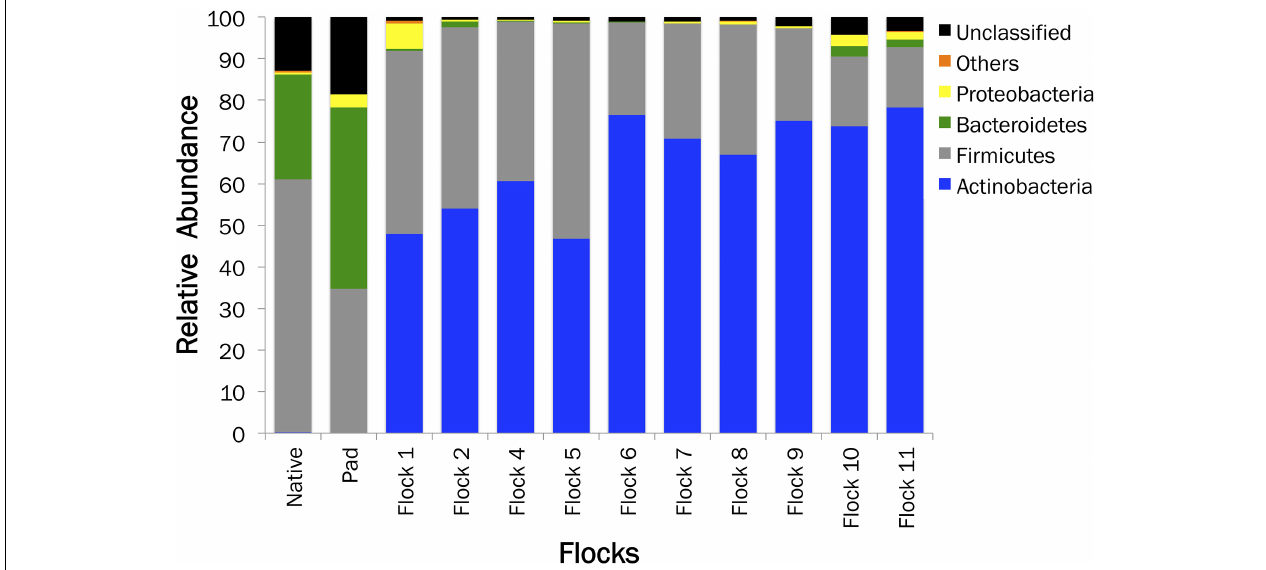
FIGURE 2 | A histogram showing the relative abundances of bacterial phyla associated with Native, Pad, and Flock samples.